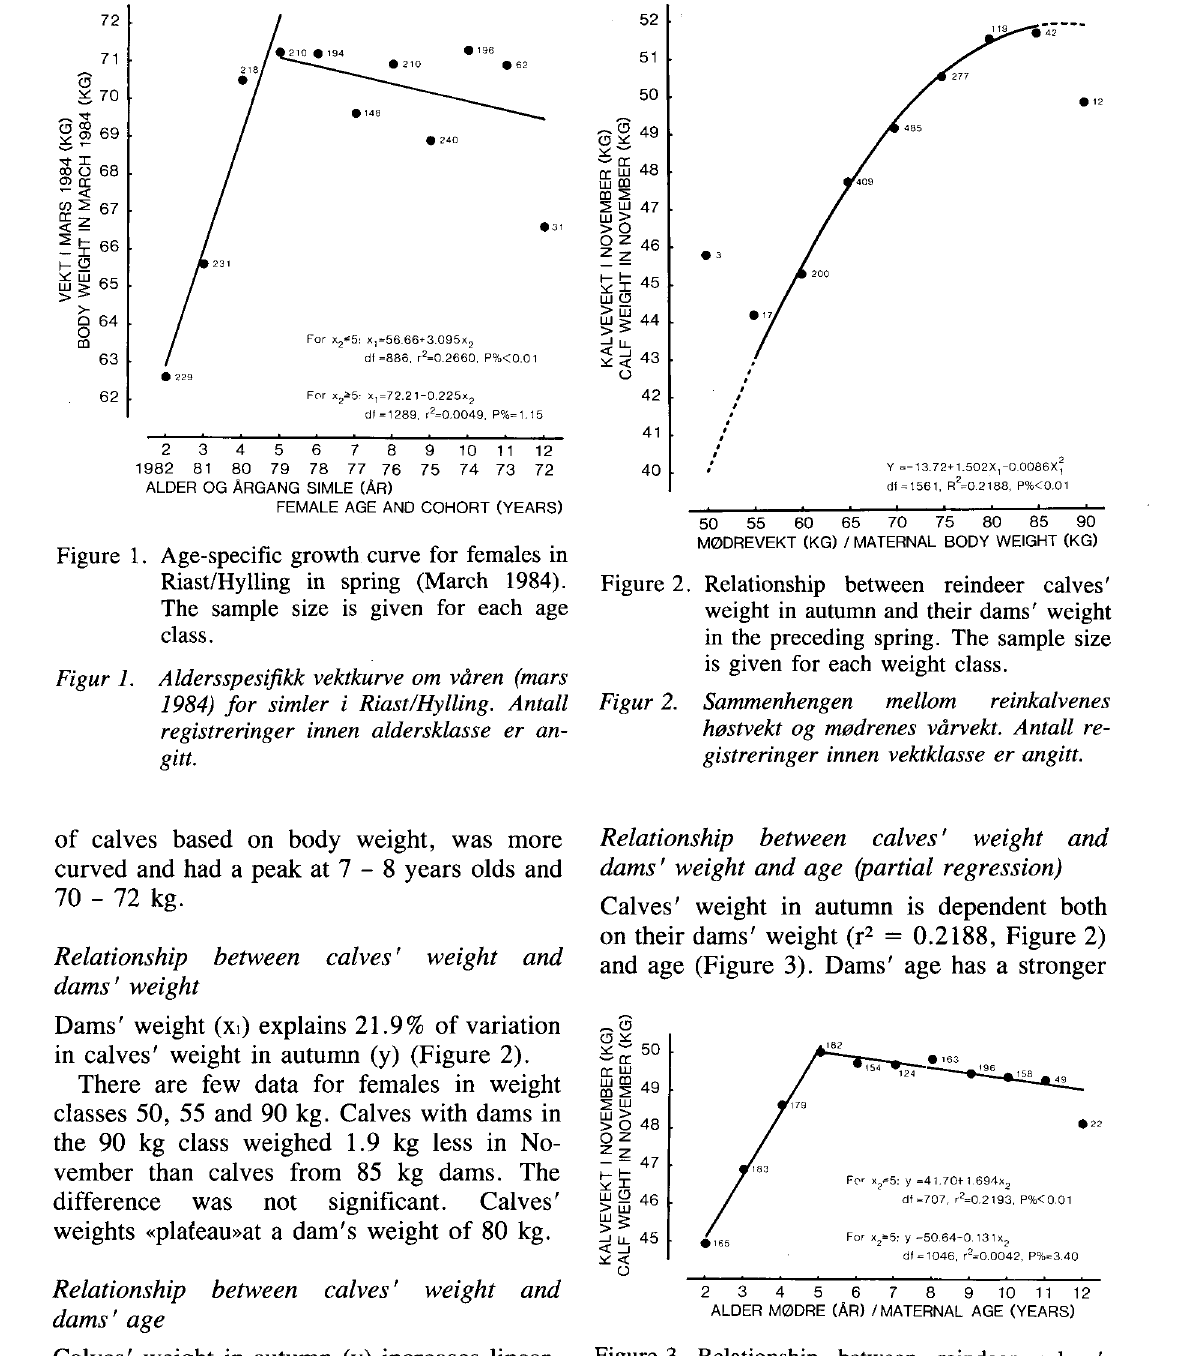
Figure 3. Relationship between reindeer calves' weight in autumn and their dams' age. The sample size is given for each age class. Figur 3. Sammenhengen mellom reinkalvenes høstvekt og mødrenes alder. Antall re gistreringer innen aldersklasse er